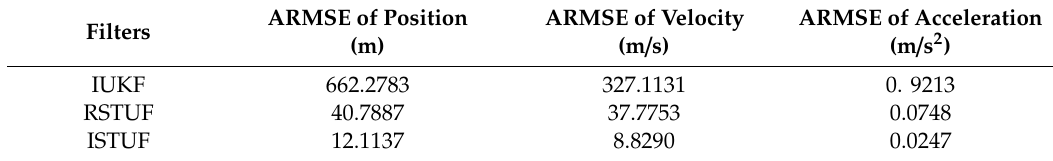
Table 3. The ARMSE of the three filters.